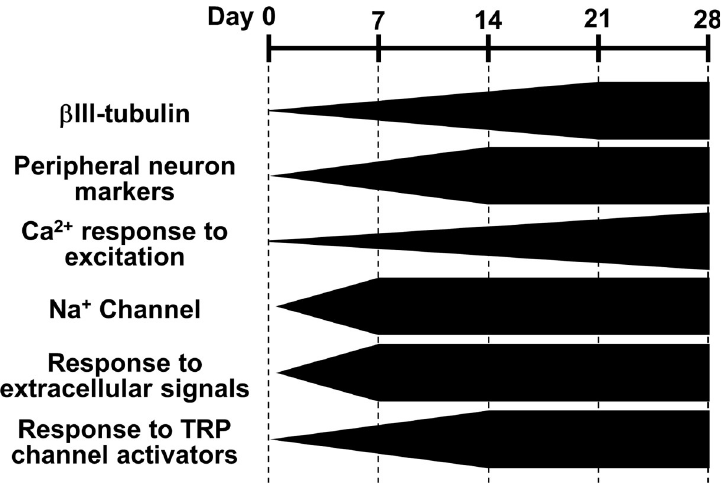
Fig 8. Summary of the differentiation of hDPSCs to peripheral neurons in each aspect revealed in this